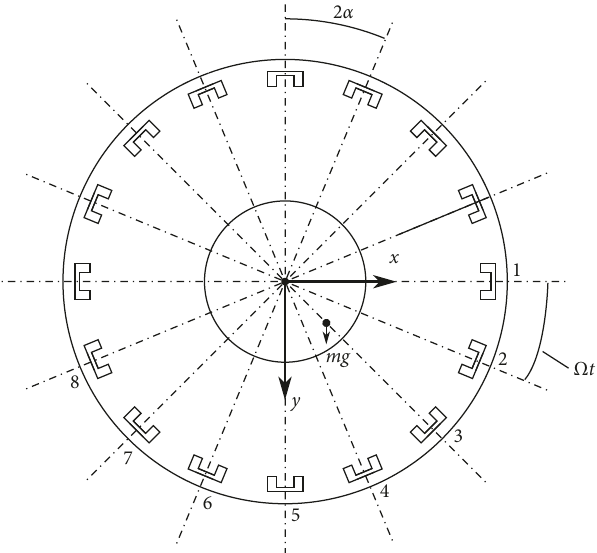
Figure 1: Cross-sectional diagram of the AMB with 16-pole